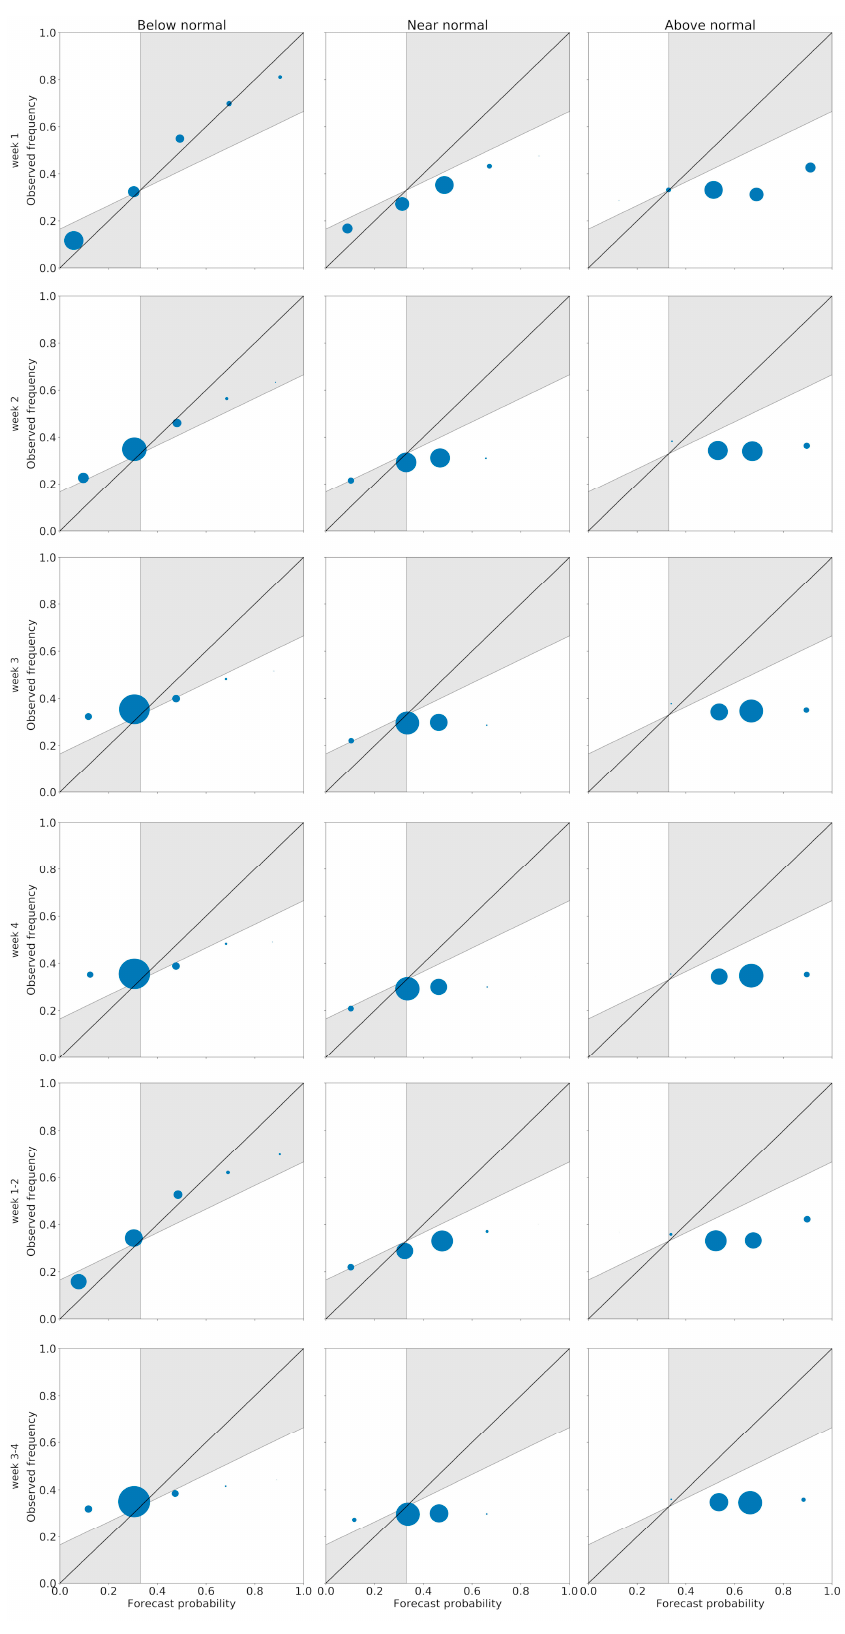
Figure 12. Same as Figure 11, but for week 1, week 2, week 3, week 4, week 1–2, and week 3–4 forecasts.